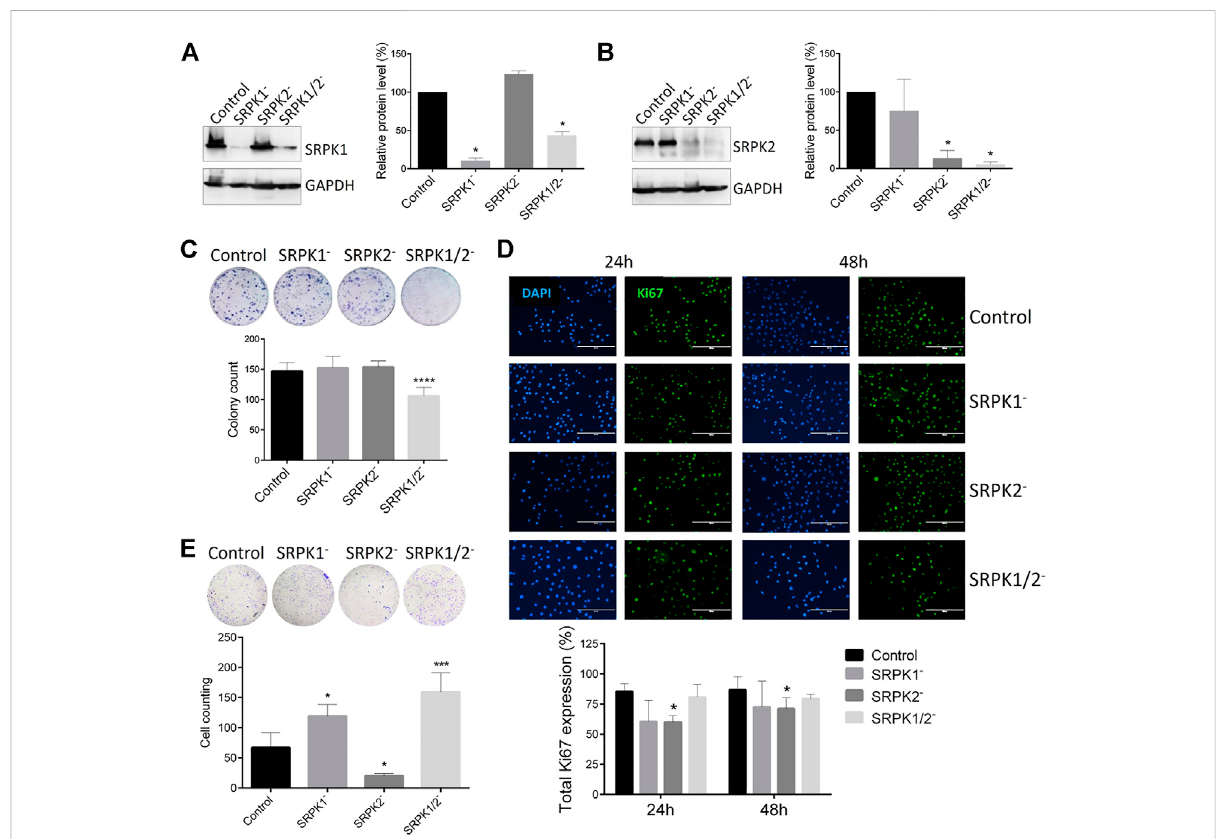
Effect of genetic targeting of SRPK1, SRPK2, or both in B16F10 cells. (A,B) Western blot analysis of B16F10 lineages generated by CRISPR-Cas9 genome edition. “ Control ” denotes cells transduced with the empty LentiCRISPRv2 vector. The SRPK1 or SRPK2 protein levels were normalized to GAPDH. The bars represent the mean ± standard deviation (SD) from duplicate experiments. (C) The clonogenic assay was performed by toluidine blue staining after 14 days. Simultaneous genetic targeting SRPK1 and SRPK2 impairs colony formation in B16F10 cells. (D) The effect of SRPK genetic targeting in cell proliferation in vitro . The cells were fi xed at 24 and 48 h and stained for Ki67, an endogenous proliferation marker. Representative images of staining are shown. The results are expressed as proliferative cells in relation to the total number of cells in each fi eld (represented by the nucleus stained with DAPI). Values in the bar graphs represent the mean ± SD (n ≥ 5 fi elds). Scale bar 200 μ m. (E) SRPK2 genetic targeting strongly decreases B16F10 invasion of B16F10 cells, while depletion of SRPK1 or simultaneous SRPK1/2 increases the invasiveness. The graph shows the quantitative analysis of the Matrigel chamber invasion. The data are expressed as the mean ± SD from triplicate experiments. * p ≤ 0.05, *** p ≤ 0.001, **** p ≤ 0.0001 versus control by Dunnett ’ s